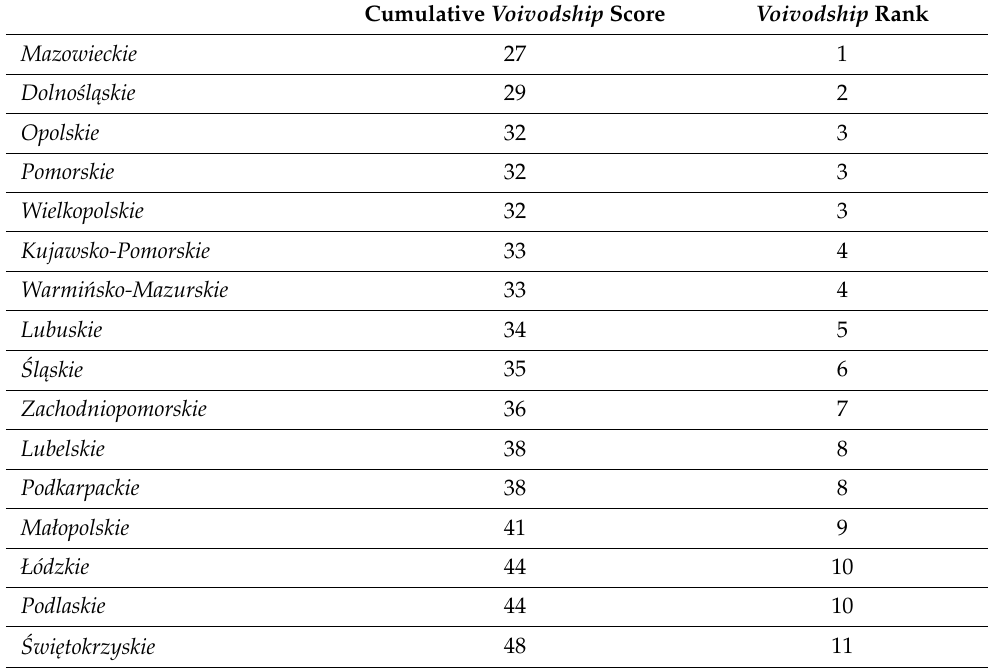
Table 16. PA adoption Cumulative Voivodships’ Score and Voivodships’ Ranking. Cumulative Voivodship